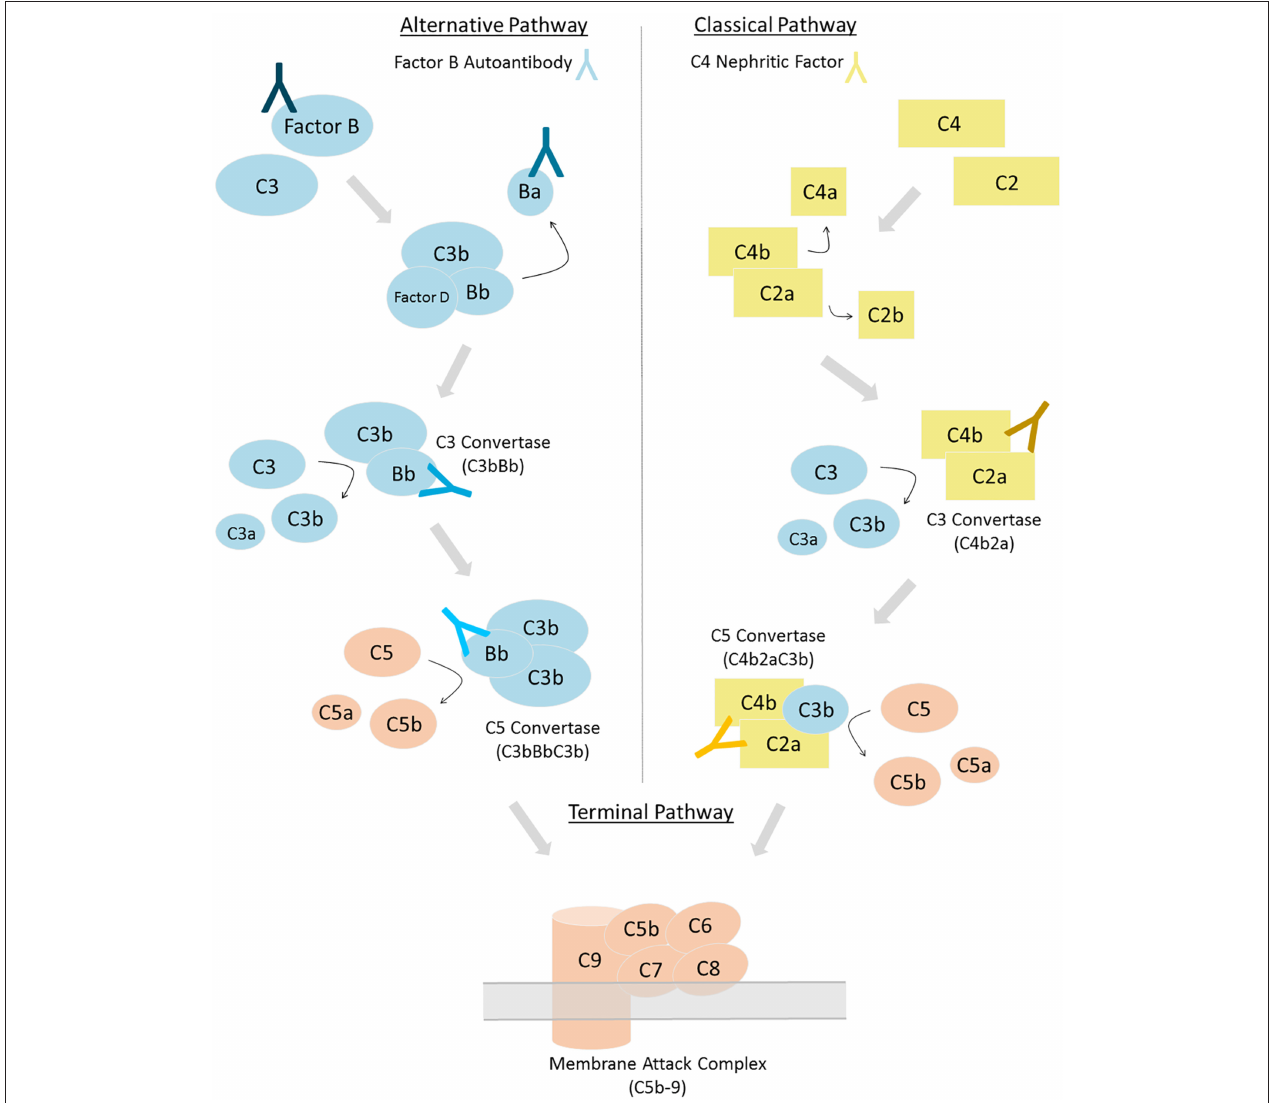
FIGURE 1 | Complement can be activated via three distinct pathways. Factor B autoantibodies bind to Factor B and/or its protein fragments generated via alternative pathway activation (left). C4 nephritic factors bind to the classical and lectin pathway’s C3 and C5 convertases (right). Differing shades of antibodies indicate possible epitopes; however, the epitope or epitopes of factor B autoantibodies and C4 nephritic factors may vary among